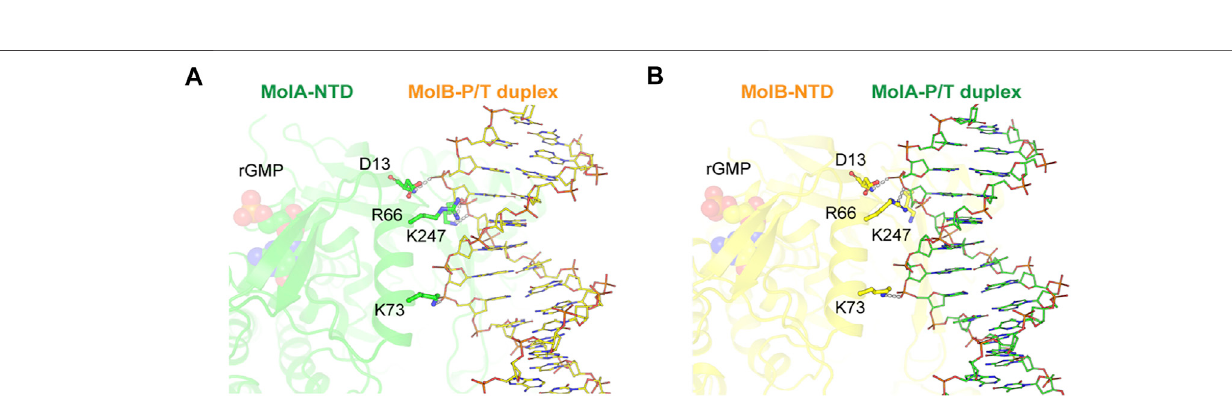
Frontiers in Molecular Biosciences |